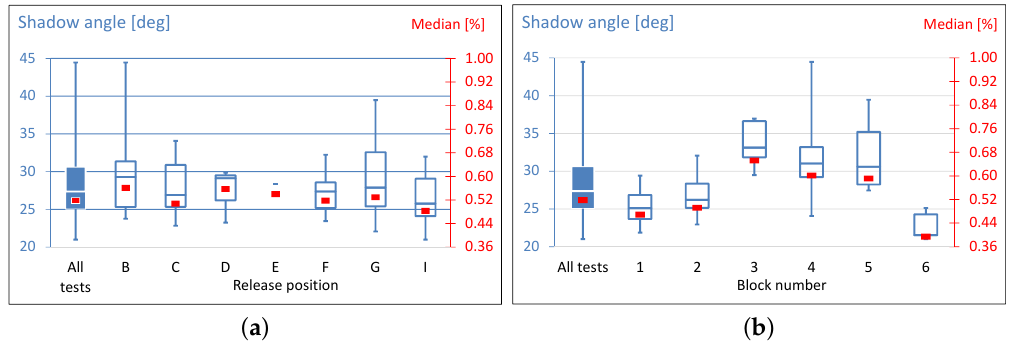
Figure 7. Boxplot of the runout of ( a ) trajectories regarding their starting points and ( b ) trajectories regarding the different test blocks. The left axes (blue) describe the shadow angle in degrees (the thin vertical lines visualize the full ranges, the horizontal lines within the boxes show the medians and the upper and lower edges of the boxes are the 25% and 75% percentiles). The right axes (red) give the median of the shadow angle in percent. The linearity of the right axes does not go along with the linearity of the left axes due to their correlation [ left axis ] = tan [ right axis ]